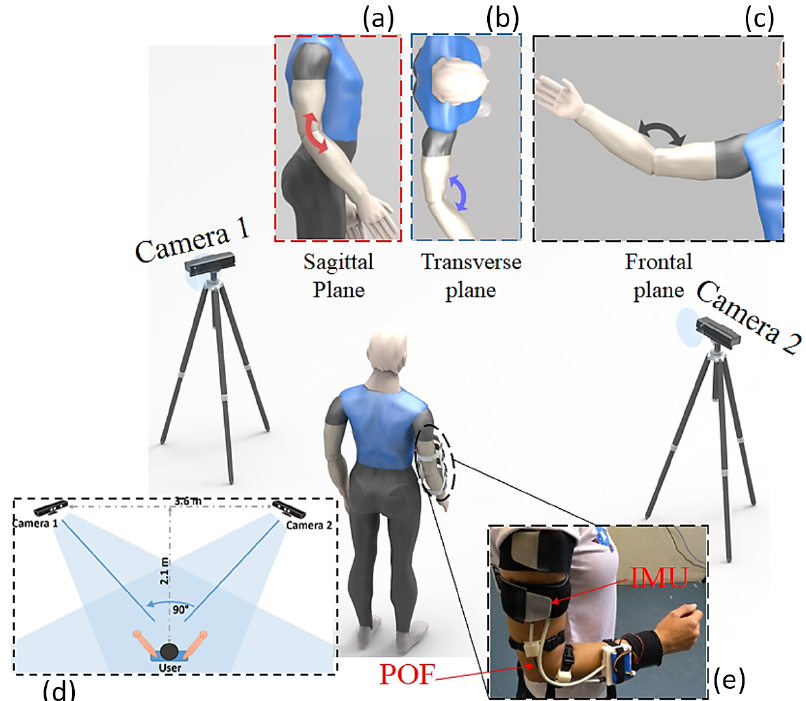
Figure 6. Sensors’ placement on the human upper limb, and movements performed during the experimental protocol. ( a ) User movement representation in sagittal plane, ( b ) transverse plane, and ( c ) frontal plane. ( d ) Top view of RGB-D system arrangement. ( e ) User using the IMU system and POF sensor.